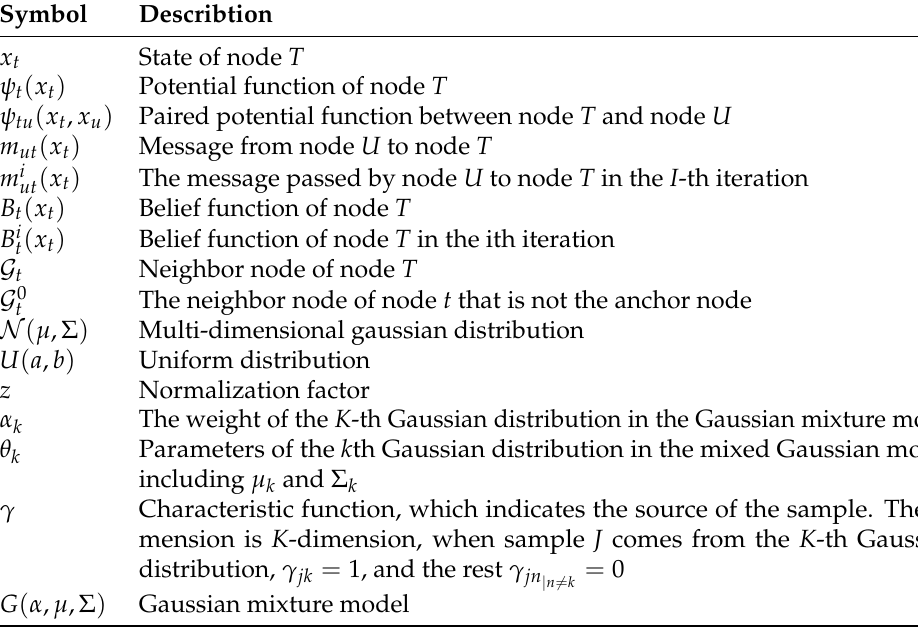
Table 1. Basic Symbols